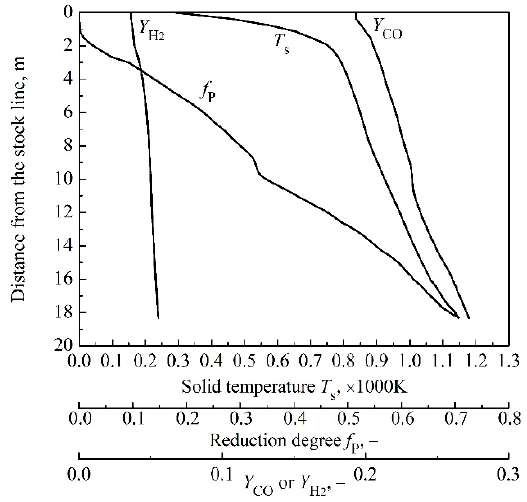
Figure 2. Baseline case results: Volume fraction of CO, volume fraction of H 2 , solid temperature, ore reduction degree in indirect reduction region.